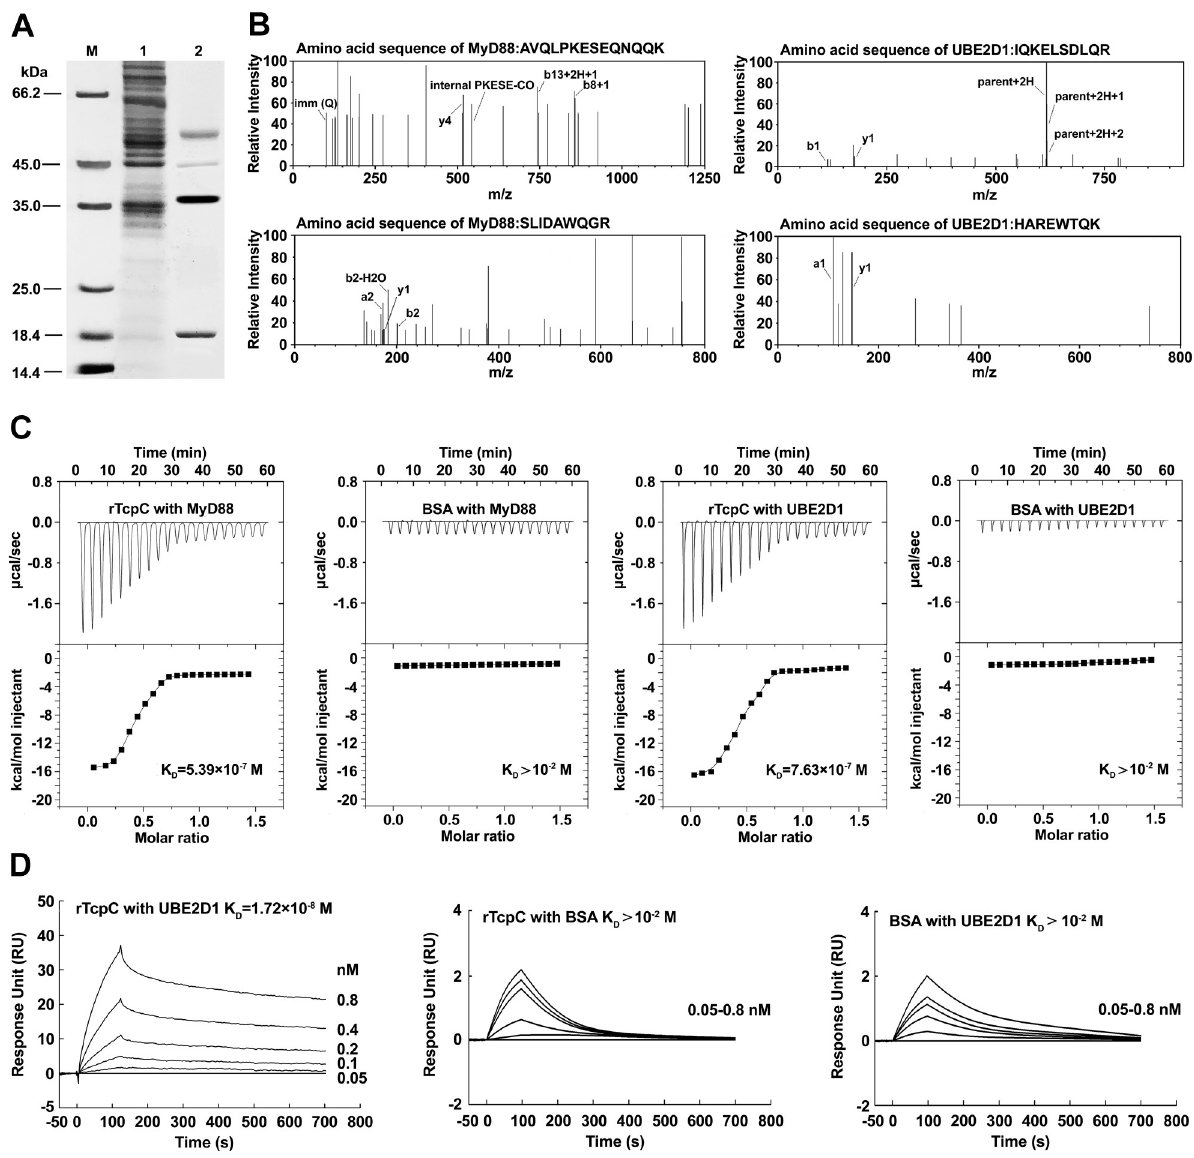
Fig 5. rTcpC specifically binds to UBE2D1 and MyD88 with high affinity. (A) Co-precipitation test showed the rTcpC binding proteins in J774A.1 lysates. Lane M: protein marker. Lane 1: total lysates of J774A.1. Lane 2: proteins released from protein-A-rTcpC-IgG beads. (B) LC-MS/MS analyses cleaved peptide sequences from TcpC-binding proteins. (C) ITC determination of the binding ability of rTcpC with MyD88 and UBE2D1. (D) SPR determination of the binding ability of rTcpC with UBE2D1.